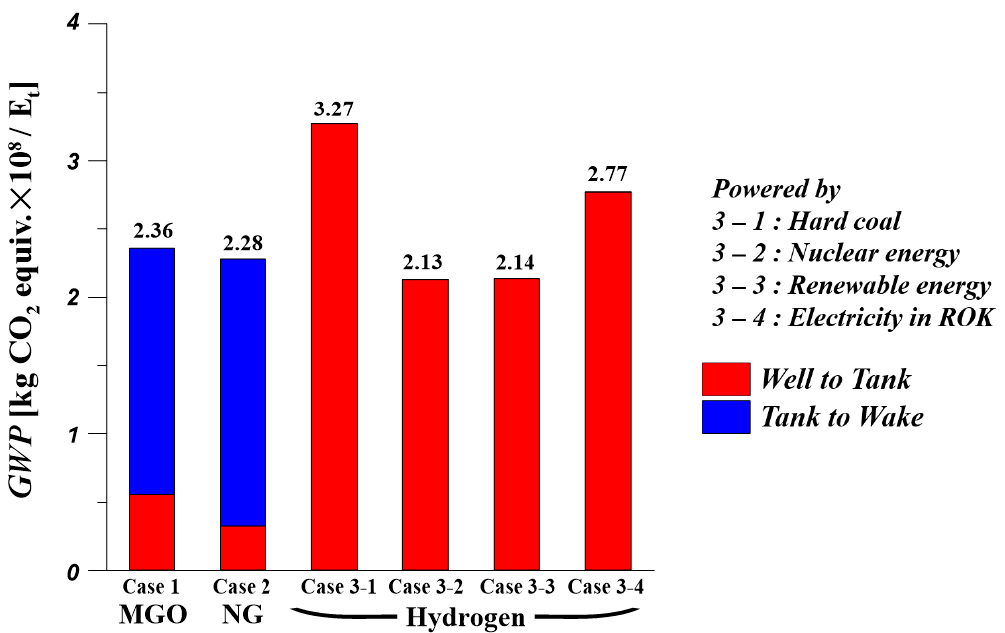
Figure 10. GWP in the Well-to-Wake phase from MGO, natural gas, and hydrogen.